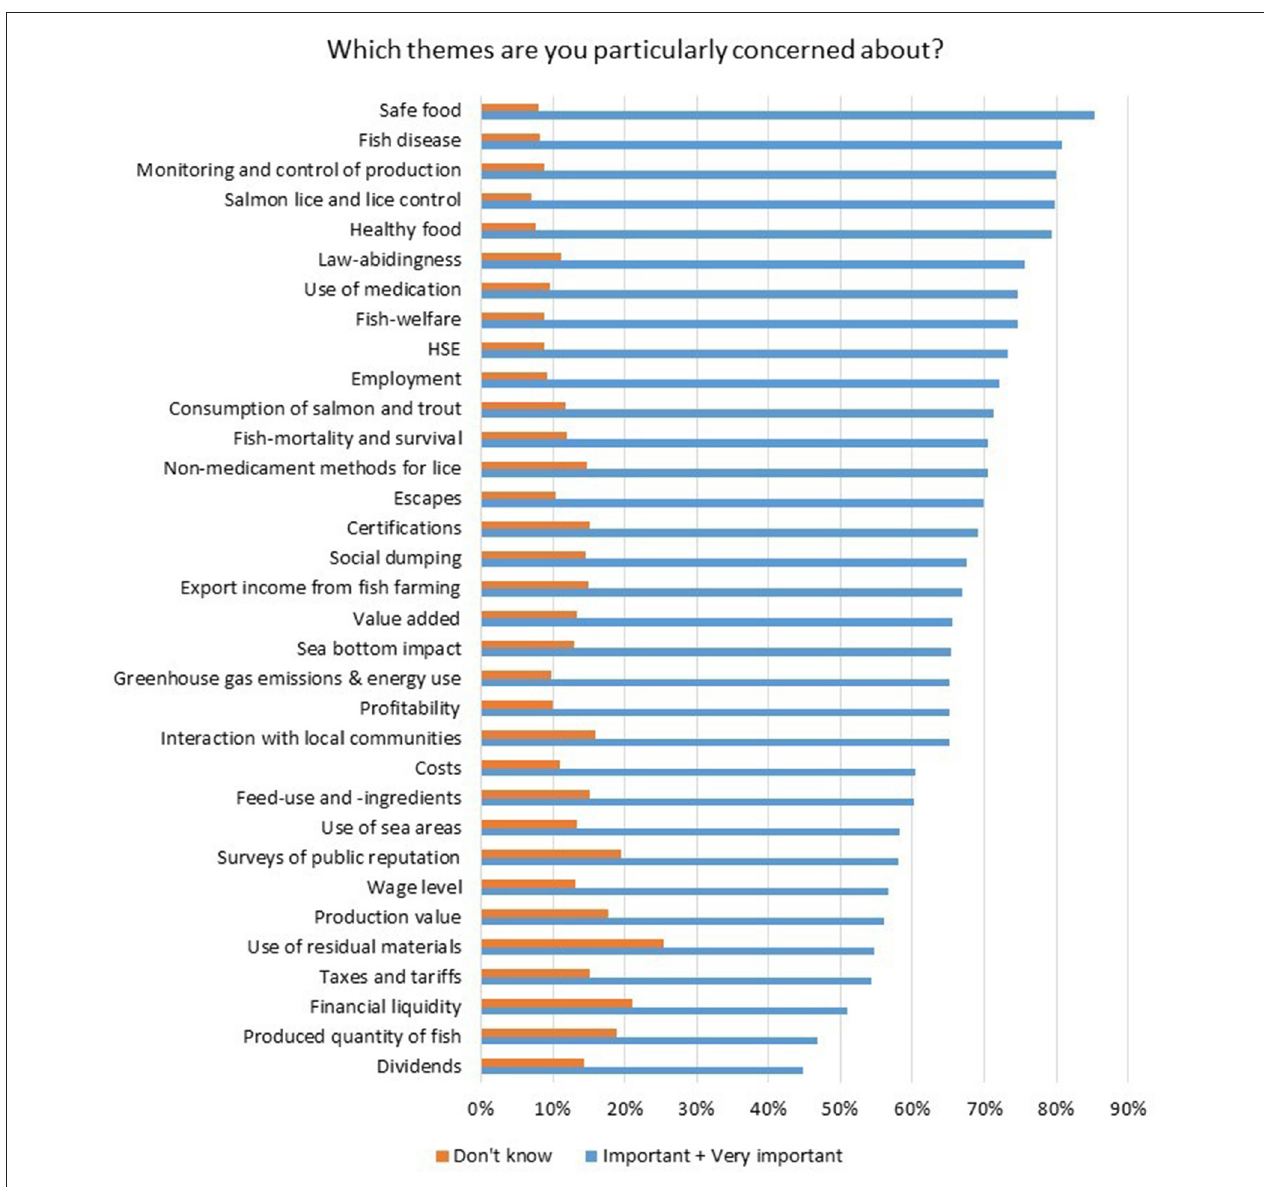
FIGURE 2 | Survey results: Share of respondents that find themes on aquaculture “Important” or “Very important,” or do not know.